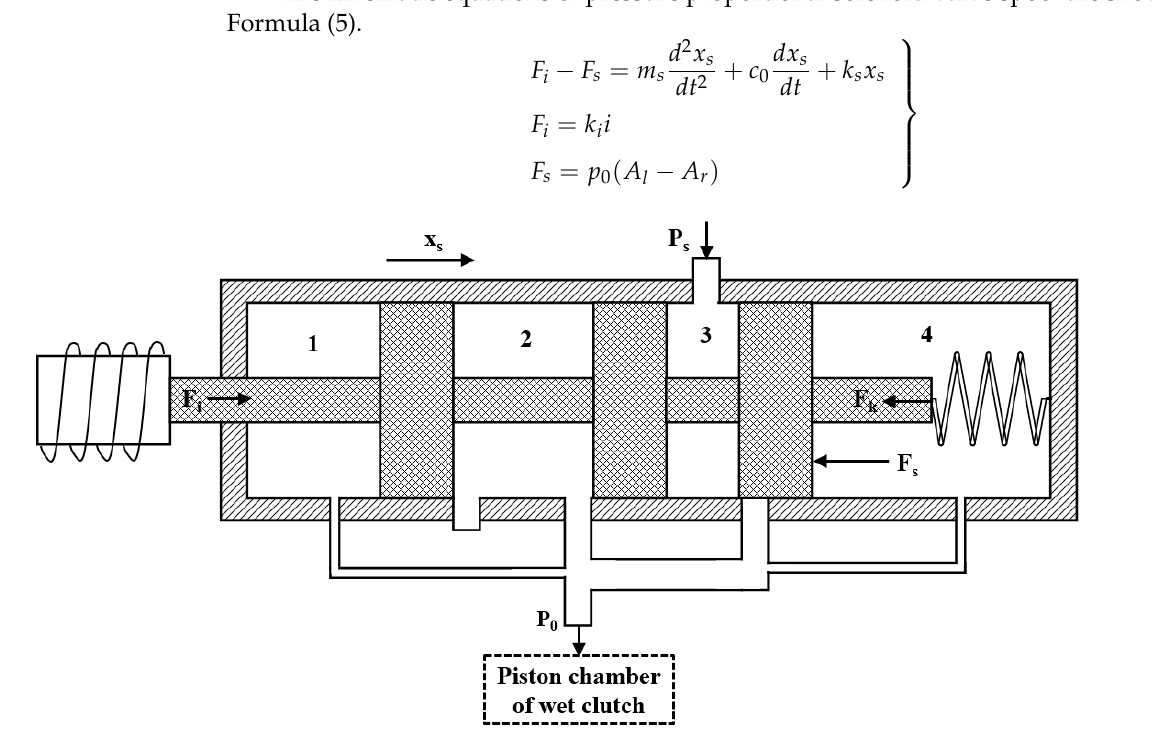
Figure 1. Schematic diagram of the pressure-proportional solenoid valve.